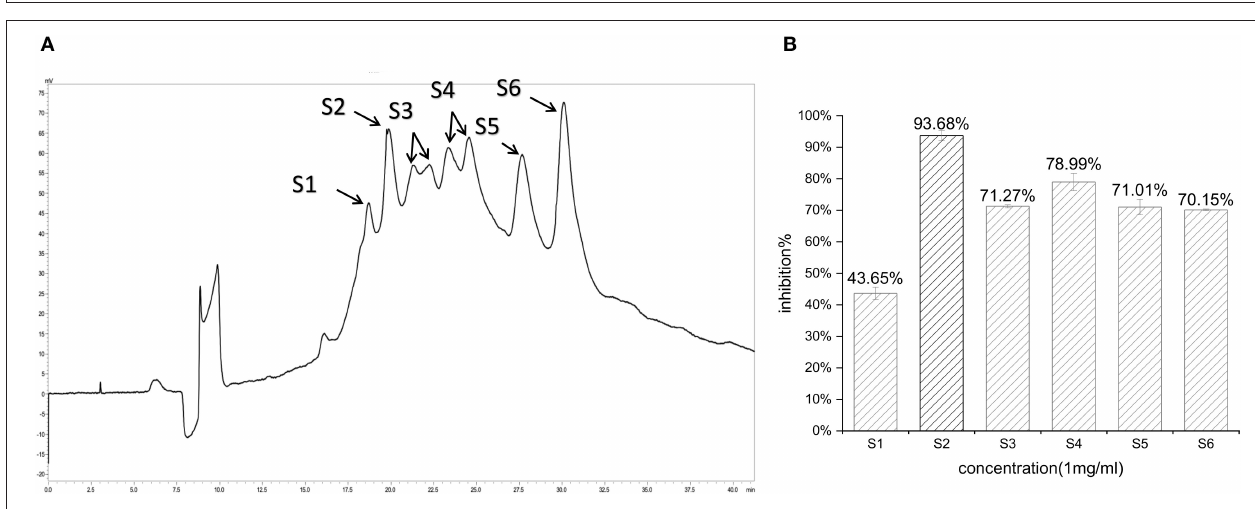
Frontiers in Nutrition |